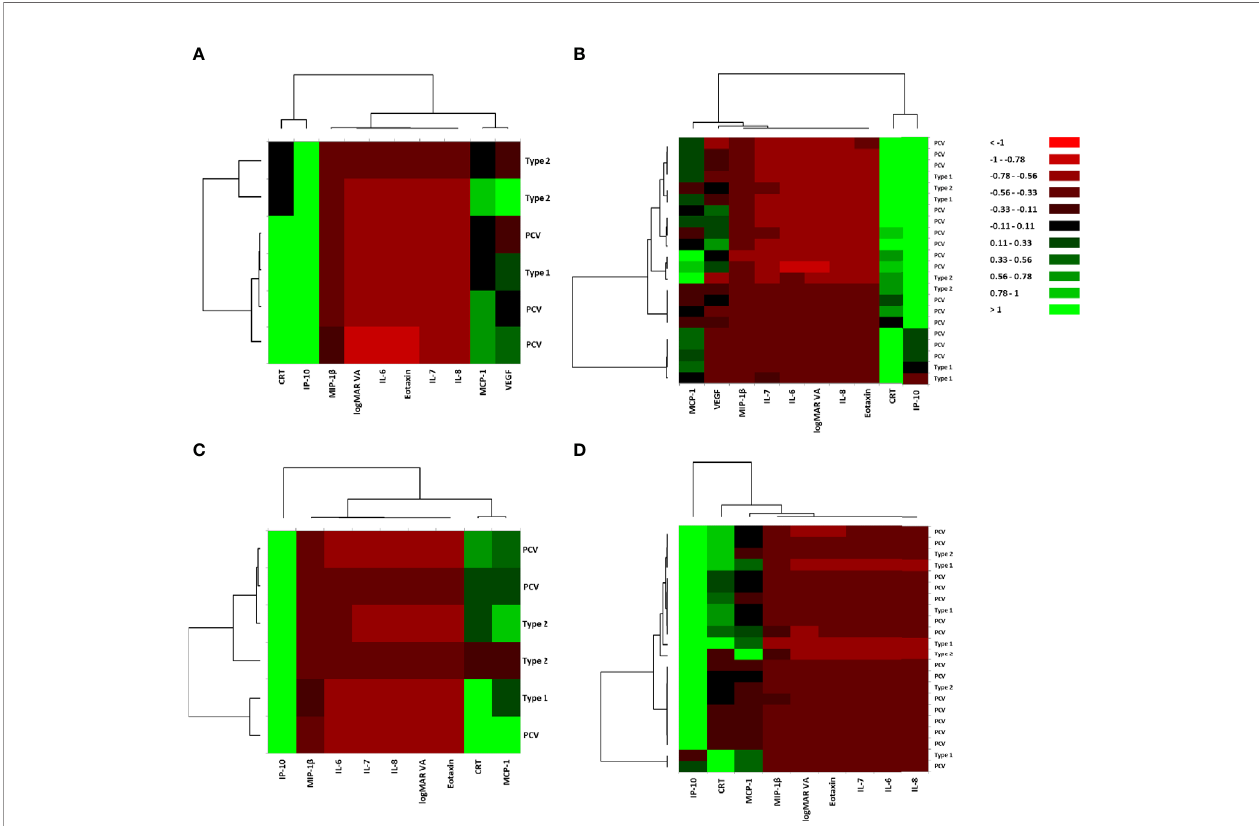
FIGURE 2 | Hierarchical cluster analysis for the variables of visual acuity, central macula thickness, and aqueous humor cytokines in nAMD eyes with or without incidence of macular atrophy under a fl ibercept treatment. Heat maps of logMAR VA, CRT, and AH cytokines in (A) MA (+) group pre-IVA, (B) MA ( − ) group pre-IVA, (C) MA (+) group post-IVA, and (D) MA ( − ) group post-IVA are shown. Color scale: low values, red; middle to high values, black to green. Vertical axis shows subtypes of nAMD, and horizontal axis demonstrates logMAR VA, CRT, and aqueous humor cytokines. AH, aqueous humor; CRT, central retinal thickness; IVA, intravitreal injection of a fl ibercept; MA, macular atrophy; MA (+) group, nAMD eyes developing MA; MA ( − ) group, nAMD eyes without MA; logMAR, logarithm of the minimum angle of resolution; nAMD, neovascular age-related macular degeneration; VA, visual